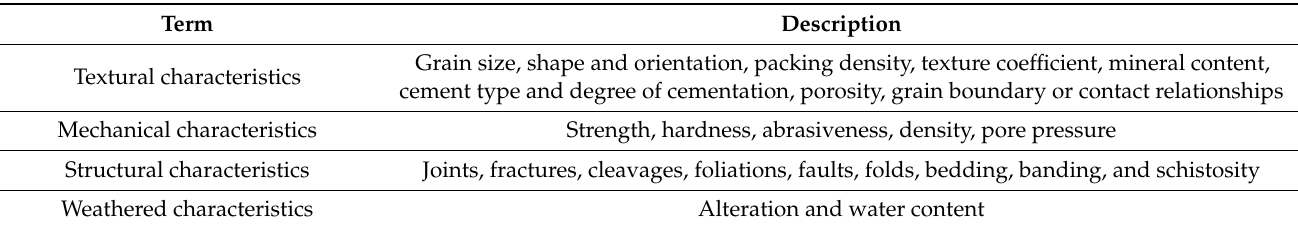
Table 1. Classifications of rock characteristics (Adapted from